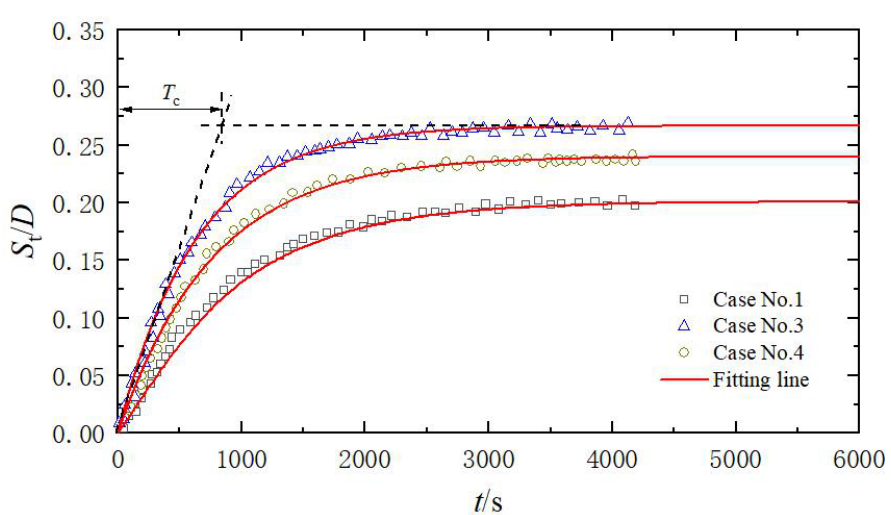
Figure 5. Temporal development of scour underneath the main column for cases 1, 3, and 4. The scour evolution curves kept fluctuating significantly when t = 4000 s, so it can be concluded that the scour did not attain equilibrium based on the equilibrium guidelines suggested by Melville and Chew [34]. Therefore, the equilibrium scour depth, S eq , was obtained using the fitting approach and Equation (19), and the S eq are listed in Table 1.